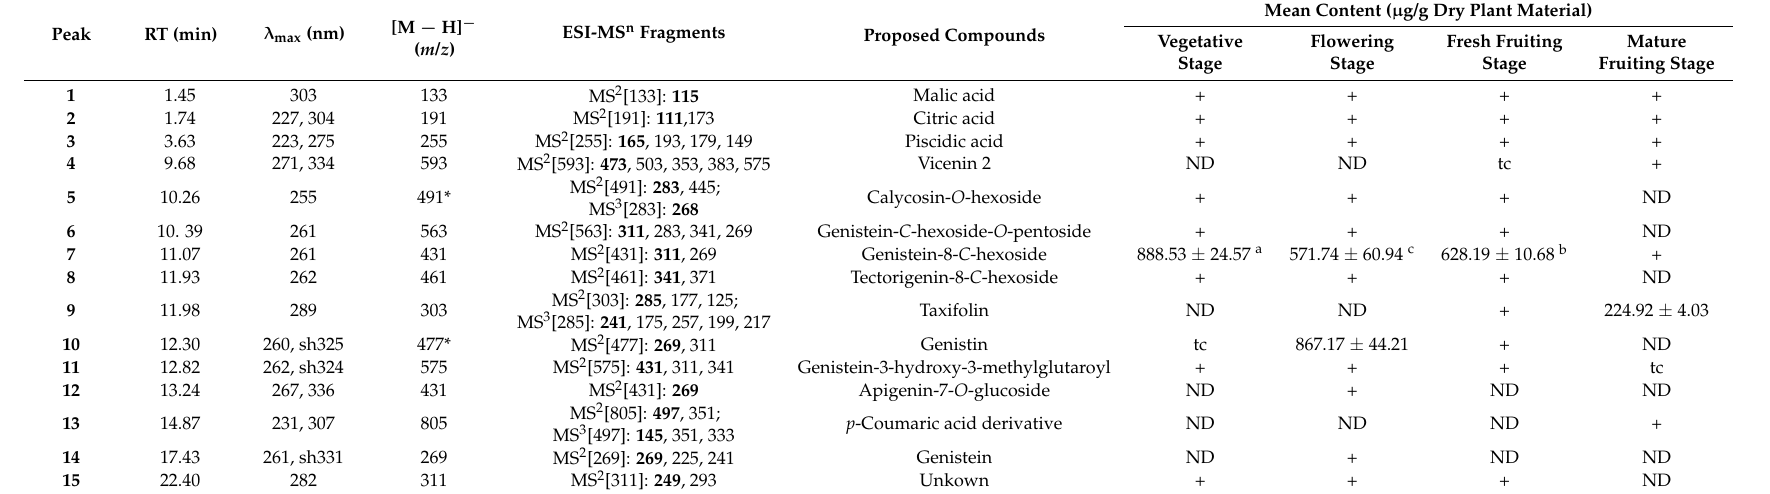
Table 3. Identification and quantification of the main compounds from the four R. raetam (Forssk.) Webb stages by UHPLC-DAD-ESI/MS n